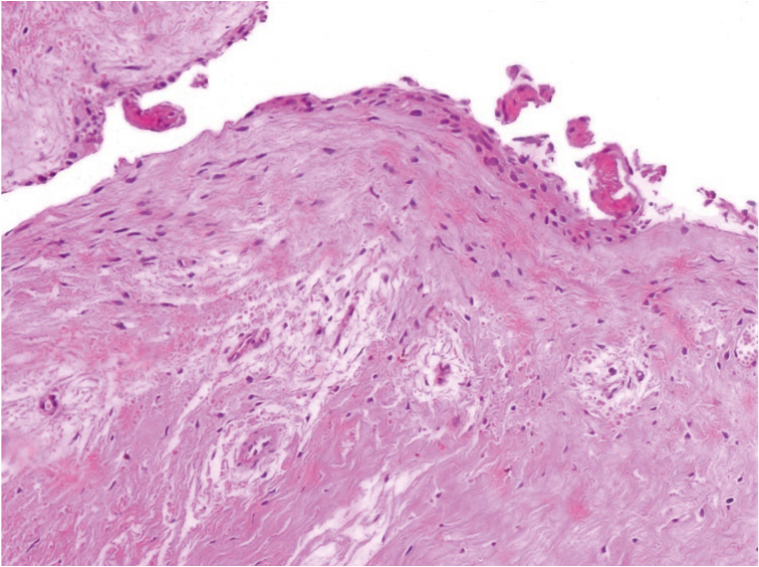
Figure 1. Histological analysis of a dental follicle from a patient under 21 years old: a) limiting enamel epithelium exhibiting discontinuity. b) connective tissue fragment. (original magnification, ×40; HE